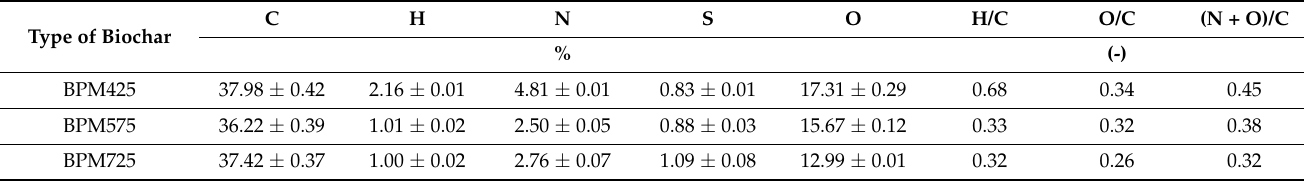
Table 4. The elemental analysis of